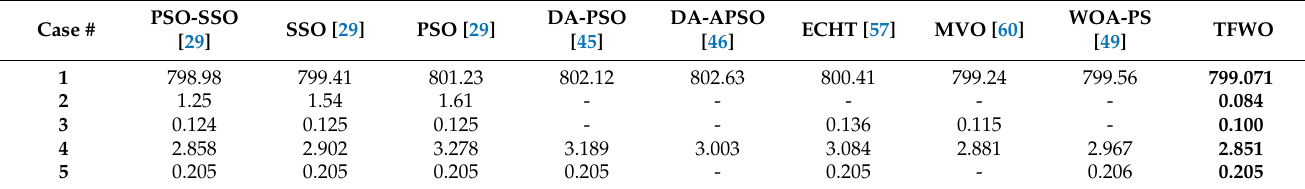
Table 3. TFWO versus recent optimization algorithms for single objective functions for the IEEE 30-bus test system.